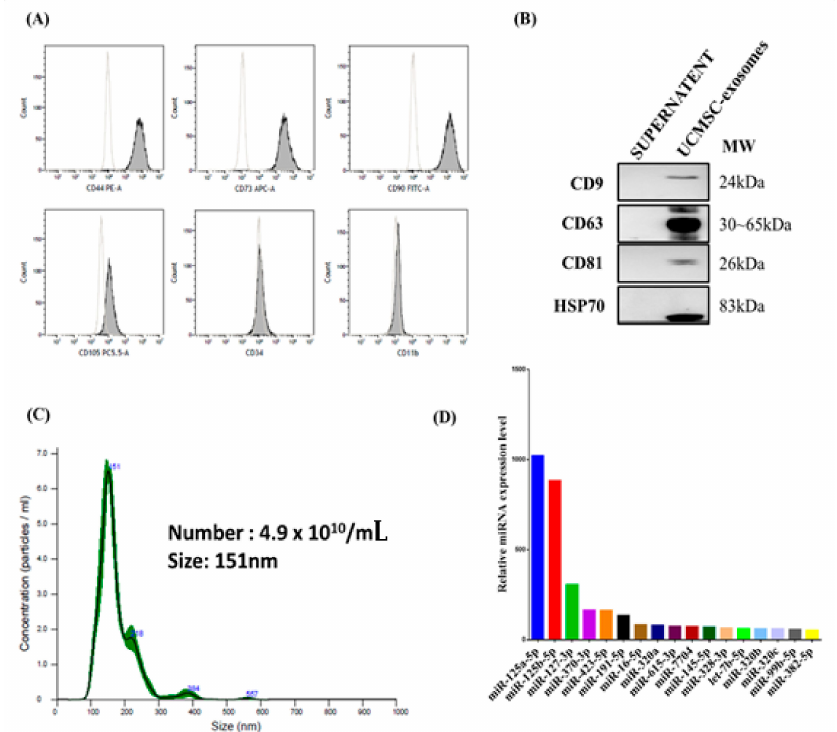
Figure 1. Isolation and characterization of human umbilical cord mesenchymal stromal cells (UCM- SCs). ( A ) Cell surface marker analyses revealed that the UCMSCs have a positive expression of CD44(+), CD73(+), CD90(+), and CD105(+) and negative expression of CD34( − ) and CD11b( − ), indicating that the UCMSCs expressed the definitive markers of MSCs. The mean intensity of CD105 expression on UCMSCs is lower. This may be related to a lower amount of CD105 ex- pression on the cell surface of USMSCs, or the antibody directed against CD105 we used might possess less avidity of binding or fluorescein conjugation. ( B ) Western blot analyses confirmed the protein expression of CD9, CD63, CD81, and HSP70 in UCMSC exosomes but not in the drop- through fraction. ( C ) The number and size of UCMSC exosomes were 4.9 × 10 10 /mL and 151 nm before concentration; after 200-fold concentration, the protein concentration was 1.13 ± 0.03 mg/mL (2.2–7.8 × 10 12 vesicles/mL). ( D ) RNA-seq analyses revealed the relative abundance of miRNAs